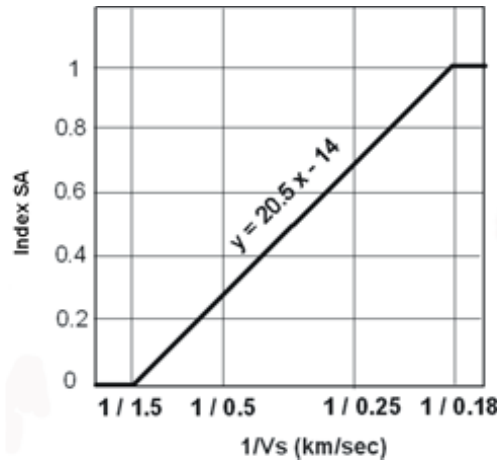
Fig. 5. Correlation between Vs values and lithology index . Modified after Rapolla et al. (2012).